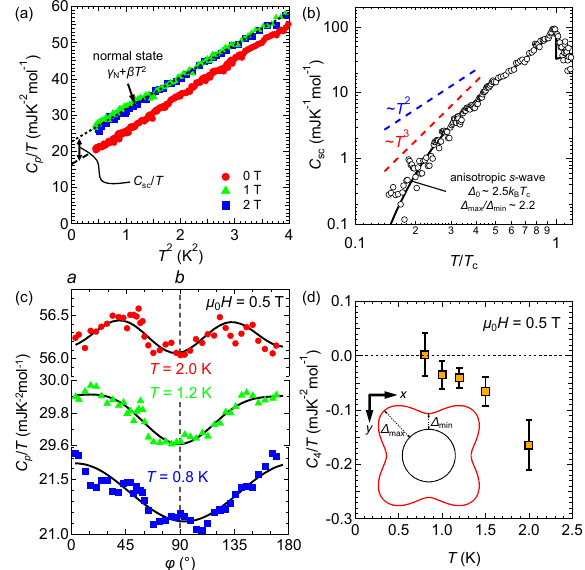
Figure 9. ( a ) Low-temperature heat capacity in various magnetic fields plotted as C p / T vs. T 2 [45]. ( b ) Electronic heat capacity related to the superconductivity C sc at 0 T. The dashed line represents T -squared relation, and the solid curve is a calculation for the anisotropic s -wave superconductivity using the gap function ∆ 0 [1 + A cos(4 φ )] 1/2 . ( c ) In-plane angle-resolved heat capacity in a field of 0.5 T rotated from the a axis (0 ◦ ) to the b axis (90 ◦ ). ( d ) Temperature dependence of the fourfold term C 4 / T . The inset is a schematic illustration of the anisotropic s -wave